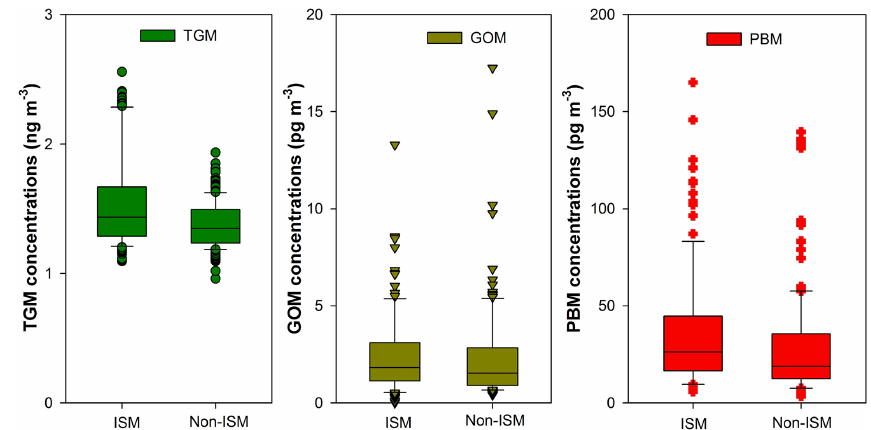
Figure 5. TGM, GOM and PBM variation during the ISM and non-ISM period based on the four sampling campaigns. TGM, GOM and PBM concentrations showed a monsoonal variation with higher level during the ISM period than in the non-ISM